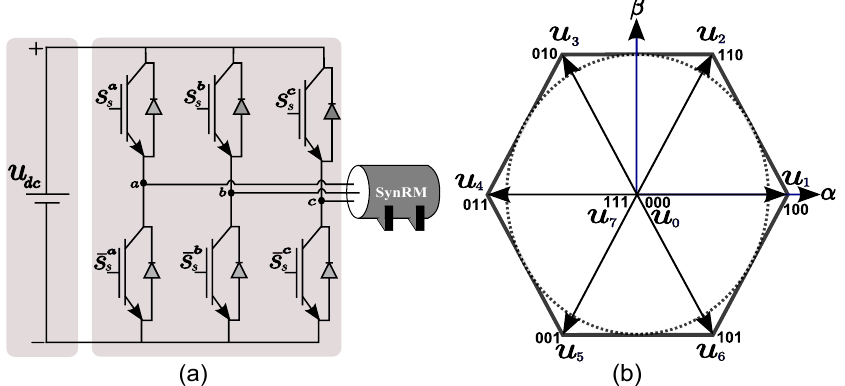
Figure 1. Three-phase two-level VSI: ( a ) Topology, and ( b ) voltage space